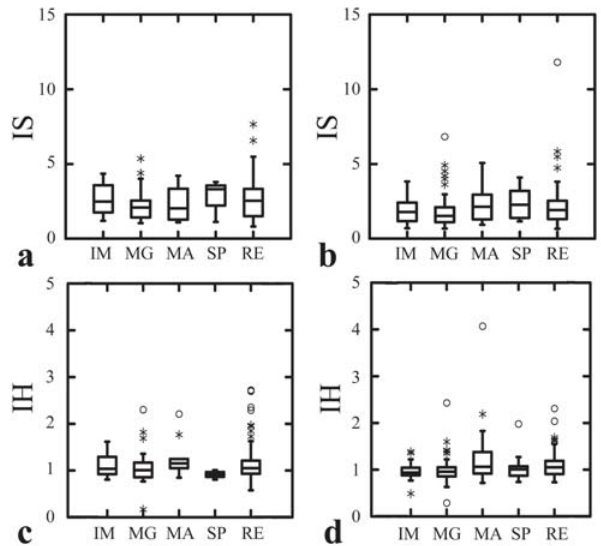
Fig. 6. Variation in the stomachsomatic index (IS) of P . mesopotamicus females and males (a, b) and hepatosomatic index (IH) of females and males(c, d), respectively, according to the stages of gonadal maturation between August 2006 and July